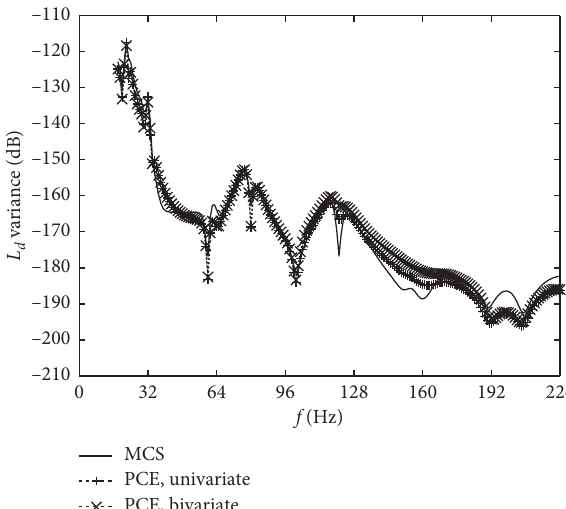
Figure 4: Error analysis curves of the dynamic compliance spectral